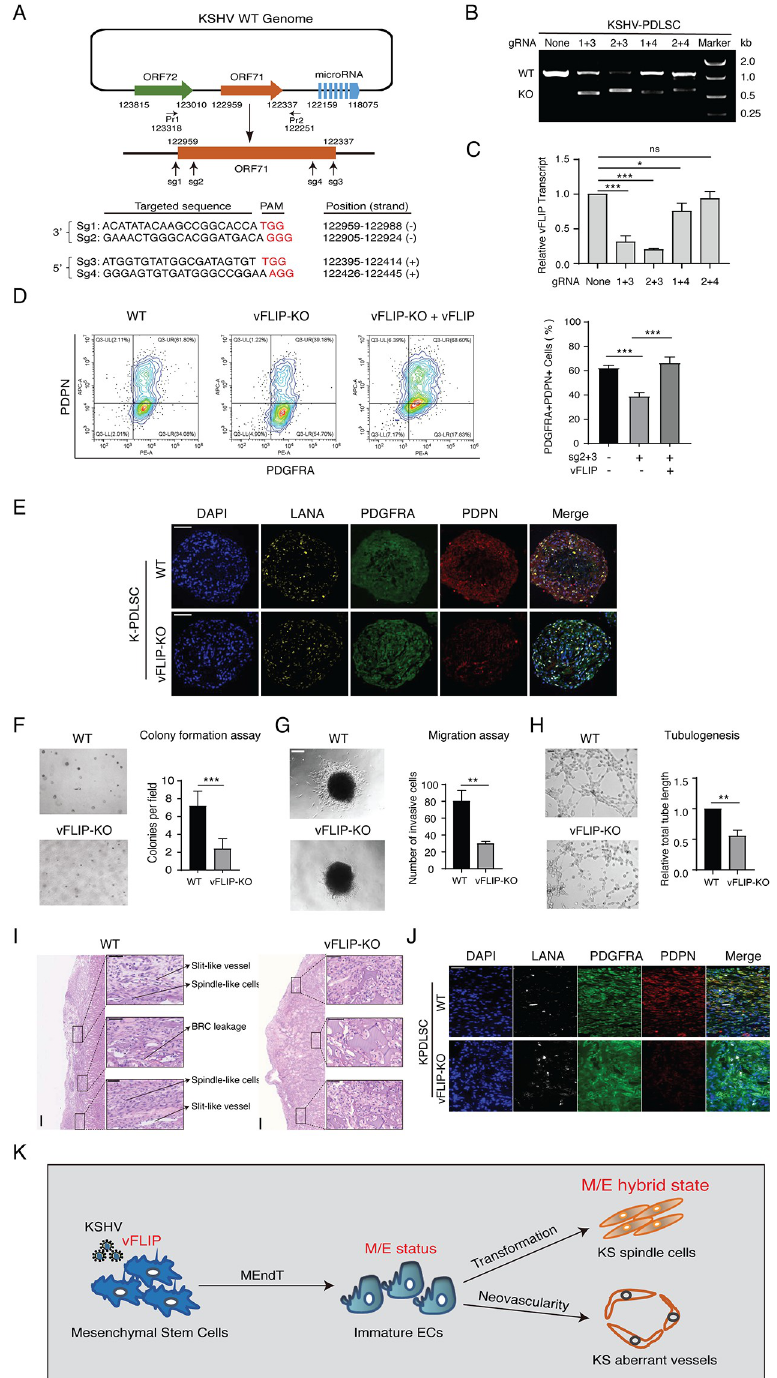
Fig 9. Silencing of vFLIP expression results in the abolishment of KSHV-induced MEndT and tumorigenesis. ( A) Schematic diagram depicting the CRISPR/Cas9 editing sites in the KSHV genome. ( B) The CRISPR/Cas9-mediated knockout efficiency of ORF71 (vFLIP) gene from the KSHV genome in KSHV-infected PDLSCs was verified by PCR with primers Pr1 and Pr2. (C) The vFLIP expression in ORF71 knockout cells was determined by RT-qPCR. ( D) The effect of vFLIP knockout (vFLIP-KO) on the generation of hybrid M/E state cells, as well as the restoration of vFLIP function by ectopic expression of sgRNA-resistant vFLIP gene (S5 Fig), was quantitated by flow cytometry. ( E) The effect of vFLIP-KO on the expression of PDGFRA and PDPN was examined with K-PDLSC spheroids by IFA. Scale bar, 50 μ m. (F) The effect of vFLIP-KO on malignant transformation ability was examined using colony formation